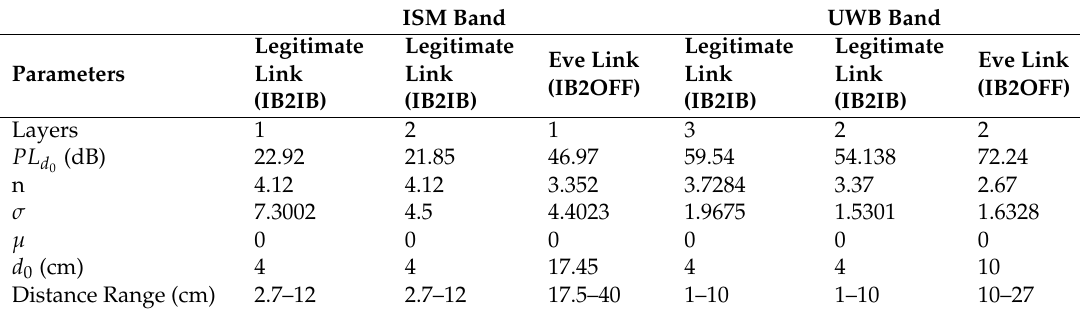
Figure 14. Path-loss Eve link without blood (IB2OFF UWB). Table 2 provides summary and comparison of path-loss models for ISM and UWB frequency band. Table 2. Summary of path-loss